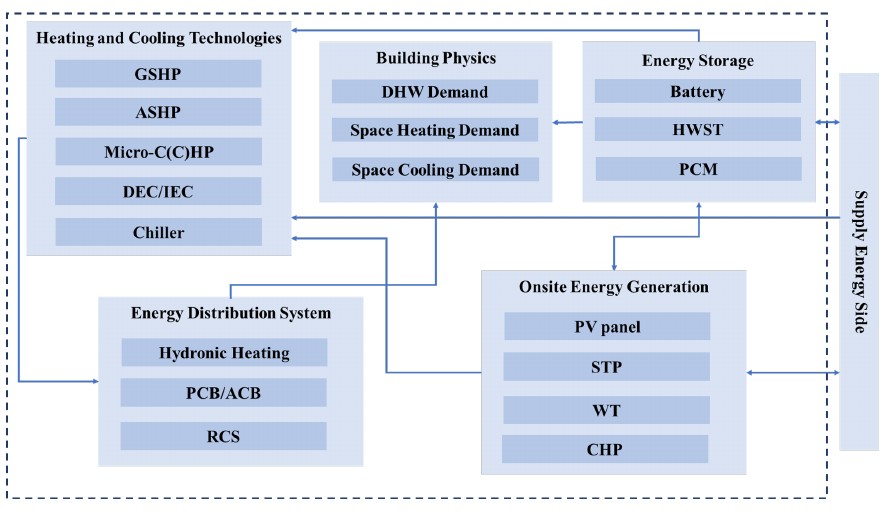
Figure 6. Schematic representation of the integration of energy